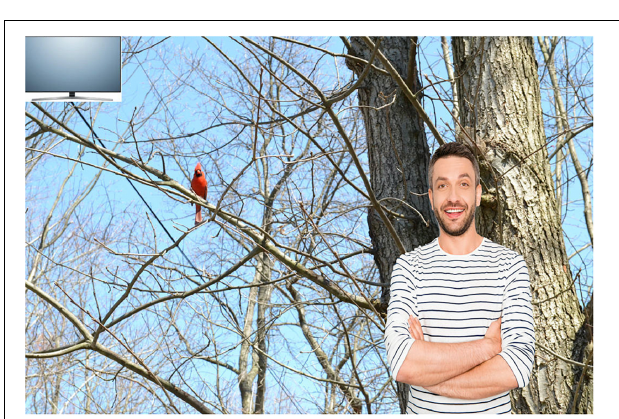
FIGURE 1 | Stimuli image used in the study (with television corner icon). Image of trees and bird: Photographer Robin Moore/used under license from Shutterstock.com. Image of person: Photographer Roman Samborskyi/ used under license from Shutterstock.com.